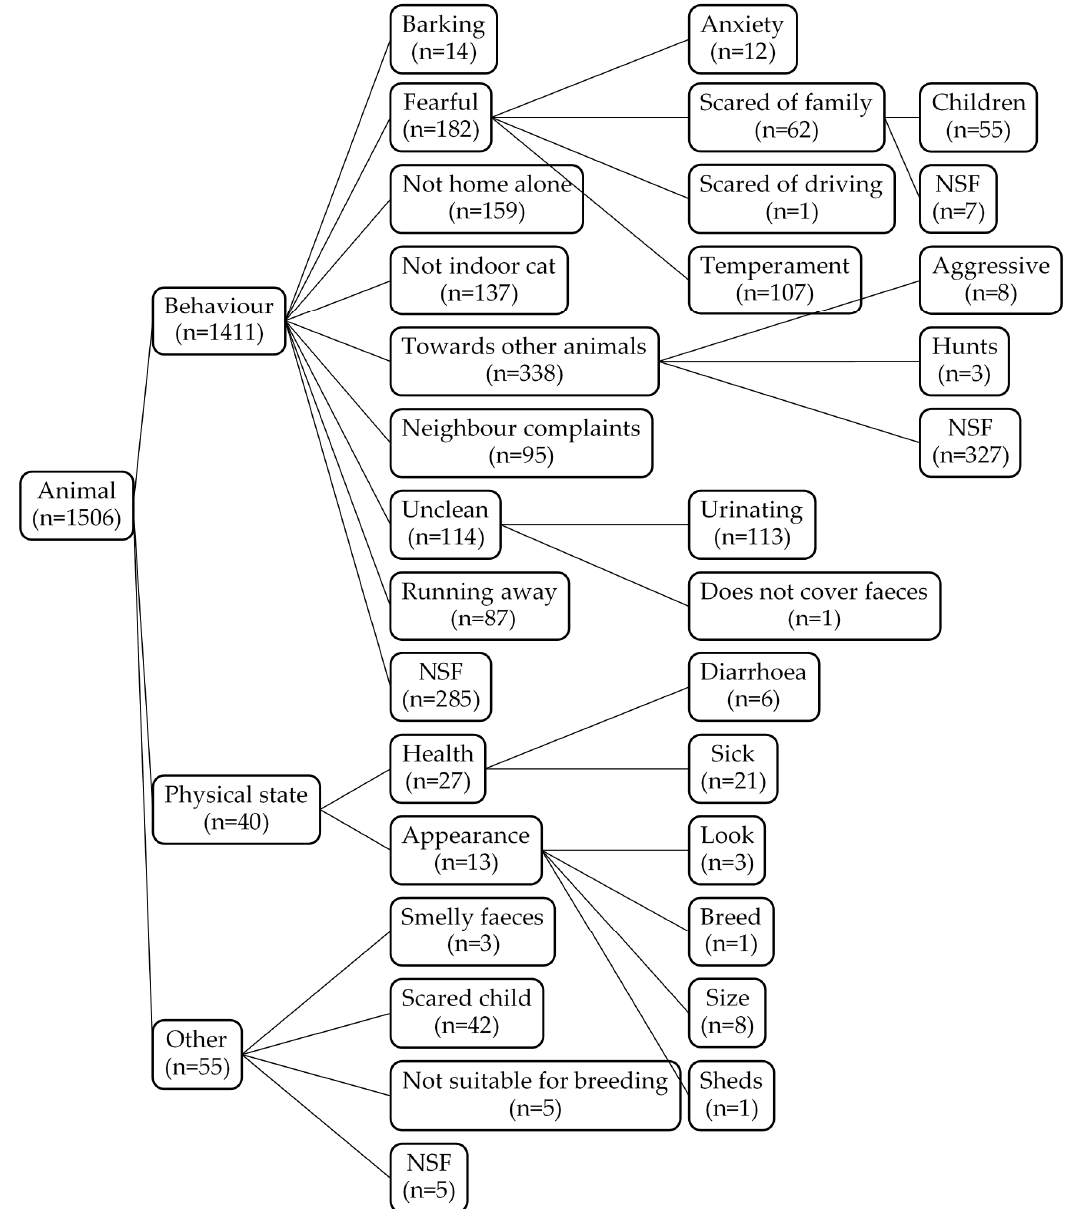
Figure 3. Reasons for relinquishment related to the animal from 1996 to 2017. Illustration of the merging and characterisation of animal-related reasons for relinquishment. NSF: not specified further.